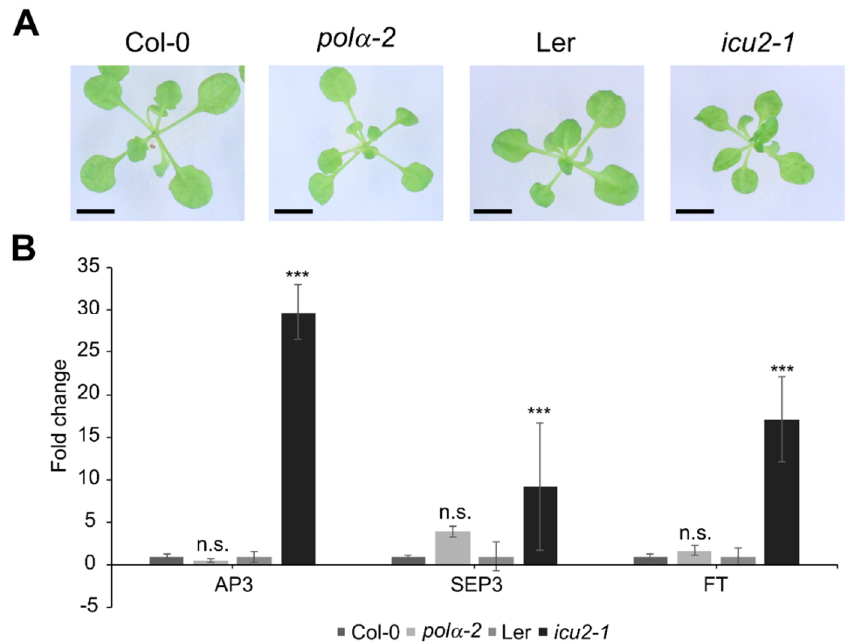
Figure 2. The pol α -2 mutation is phenotypically distinct from the described icu2-1 mutation. ( A ) Rosette phenotype of 21 − day − old wild − type (Col-0), pol α − 2 , Ler, and icu2 − 1 plants. Bars = 0.5 cm. ( B ) Gene expression levels of flowering genes in the first leaf pair of 21-day-old Col-0, pol α − 2 , Ler, and icu2 − 1 . Data represent the mean ± SEM (minimum 4 plants per repeat in 3 biological replicates), expression levels were normalized to the respective WT ecotype. Significance was tested with mixed model analysis. n.s., not significant; *** p < 0.001.